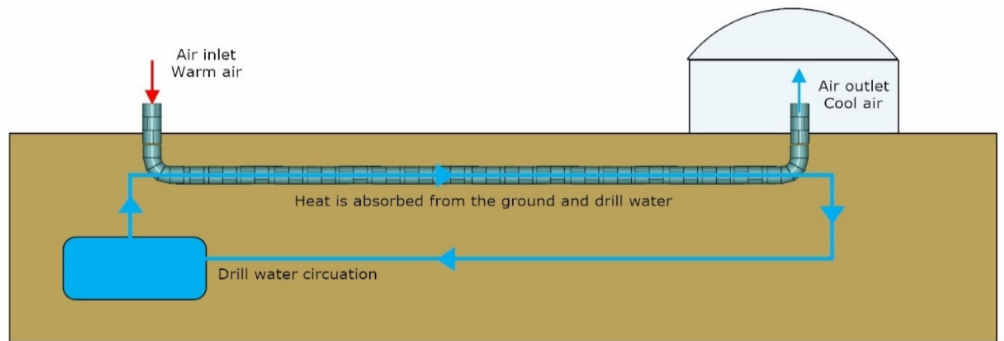
Scheme 1. Schematic description of WAEAHE operation for greenhouse